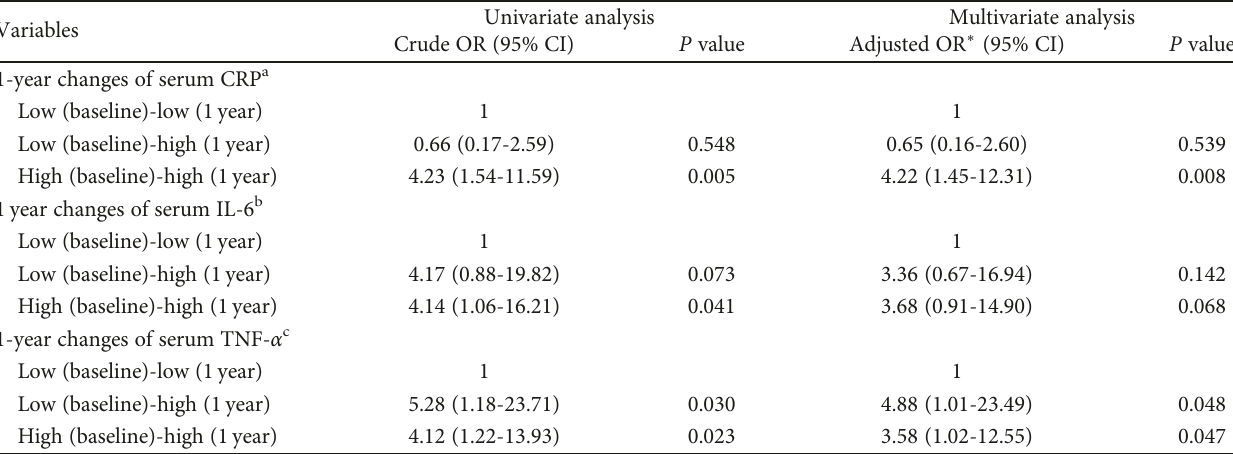
Table 5: Odds ratios (ORs) and 95% con fi dence intervals (CIs) for 2-year progression of type 2 diabetes according to 1-year changes of serum in fl ammatory marker